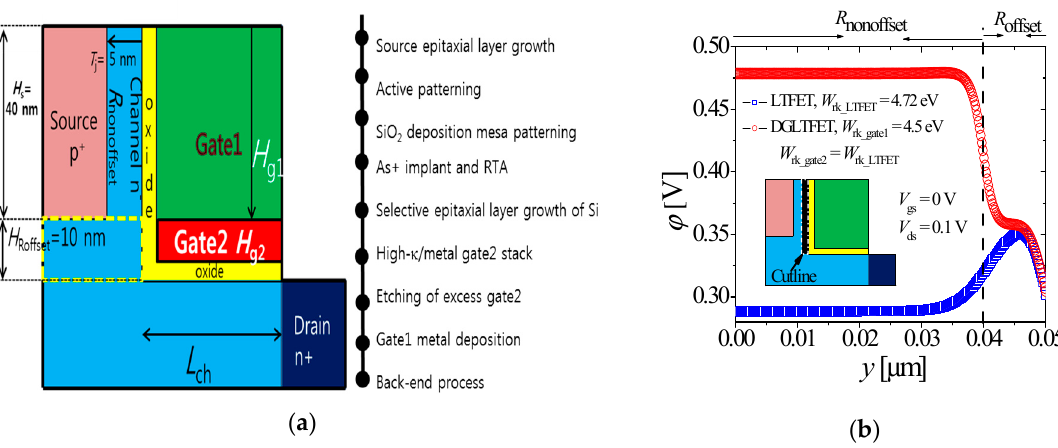
Figure 5. ( a ) Schematic of DG-LTFET with process-flow indicated alongside and ( b ) V fb of DG-LTFET (red symbols) compared with that of the LTFET (blue symbols). In the DG-LTFET, W rk_gate1 = 4.5 eV and W rk_gate2 = W rk_LTFET = 4.72 eV were used.